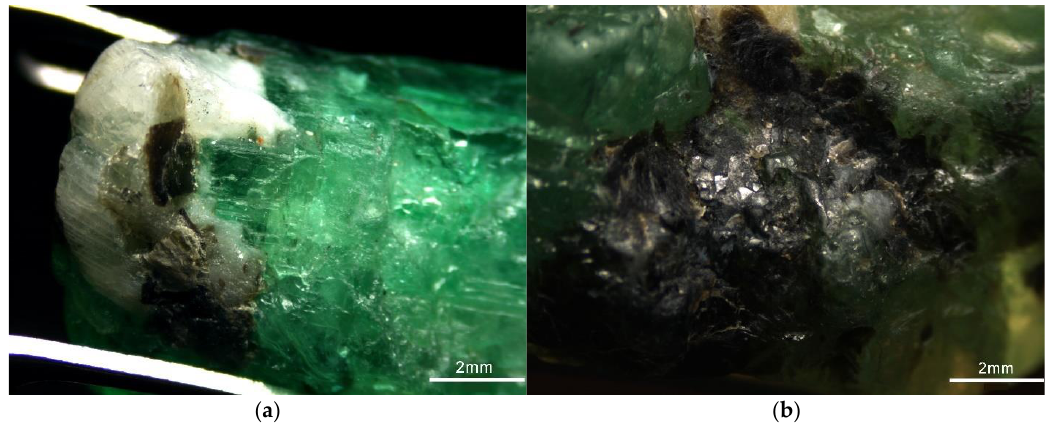
Figure 2. Indian emerald crystals (weight ranging from 2.59 to 13.31 ct in this photo) for this study.